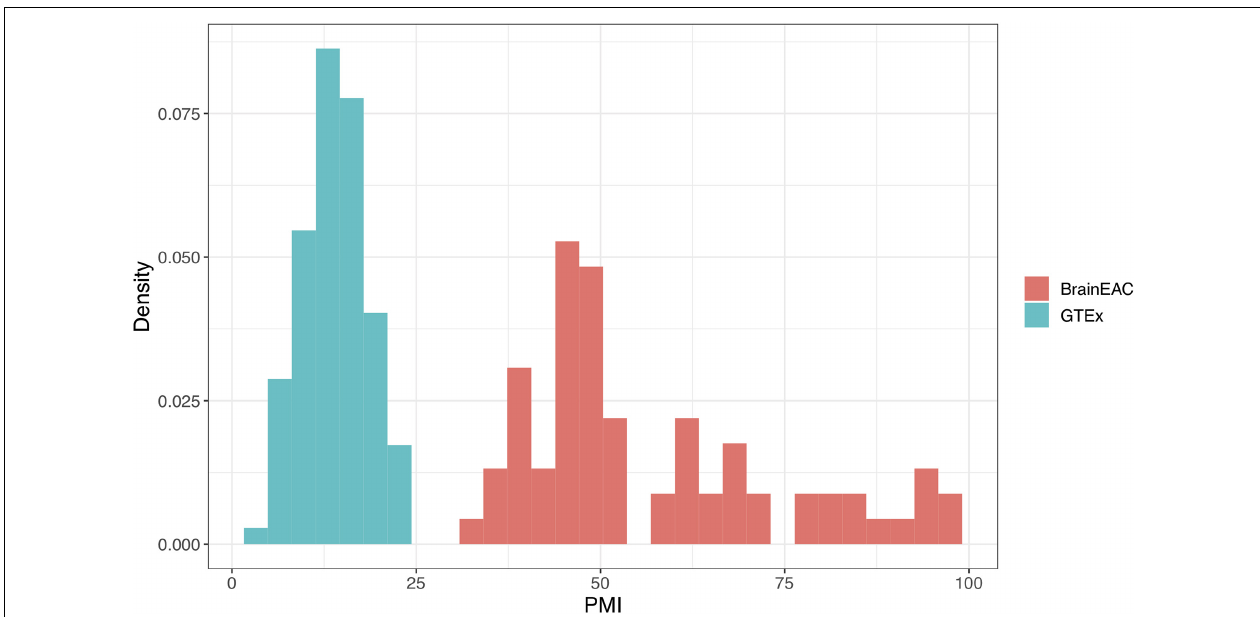
FIGURE 7 | Density plot of postmortem interval (PMI) values in hours. The genotype-tissue expression (GTEx) and BrainEAC samples are colored in blue and red, respectively.